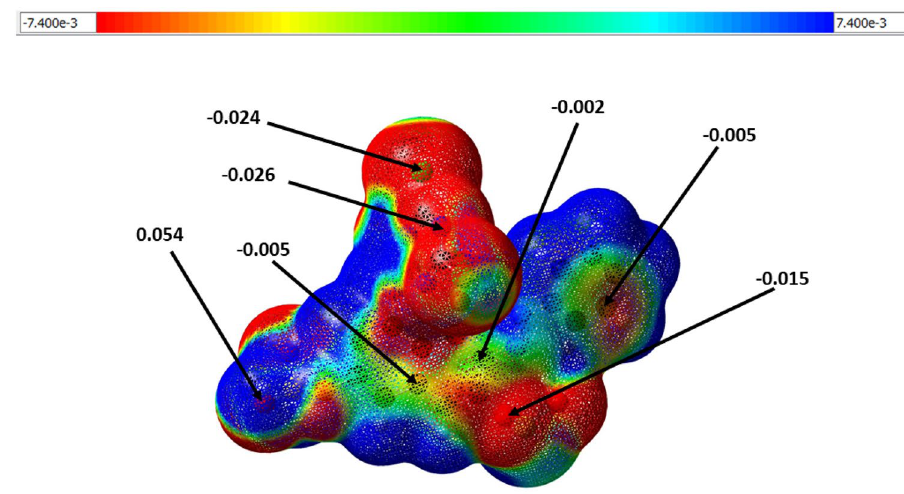
Fig. 6 The Electrostatic Poten- tial (ESP) Diagram of Cyanu- rated H-acid with Aniline (CHA) using RB3LYP method with 6-31G (d,p) basis